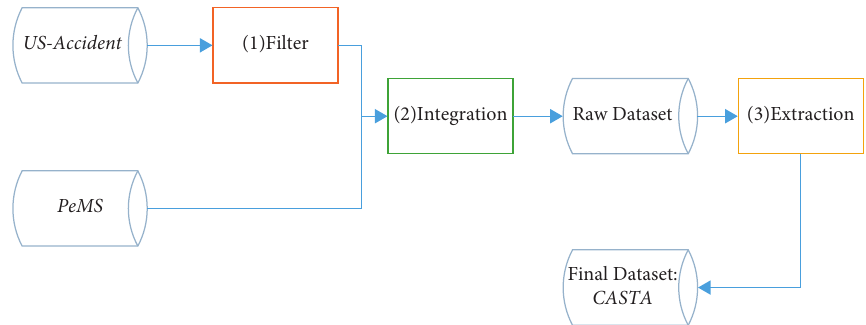
Figure 12: Process of creating spatial-temporal accident dataset